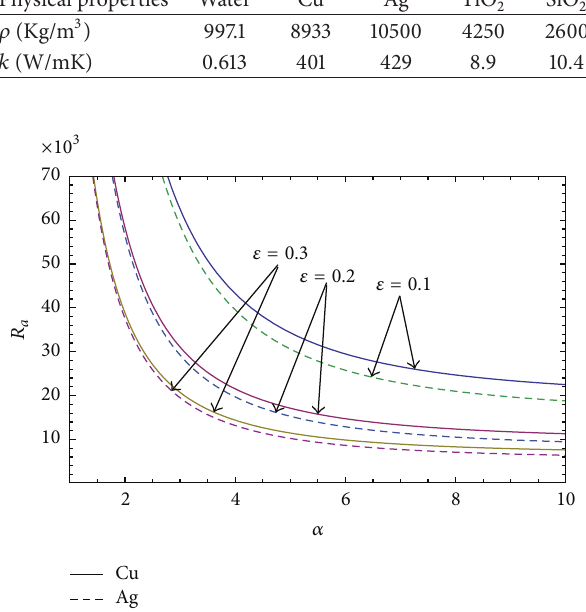
Figure 3: Effect of 𝜀 on metallic